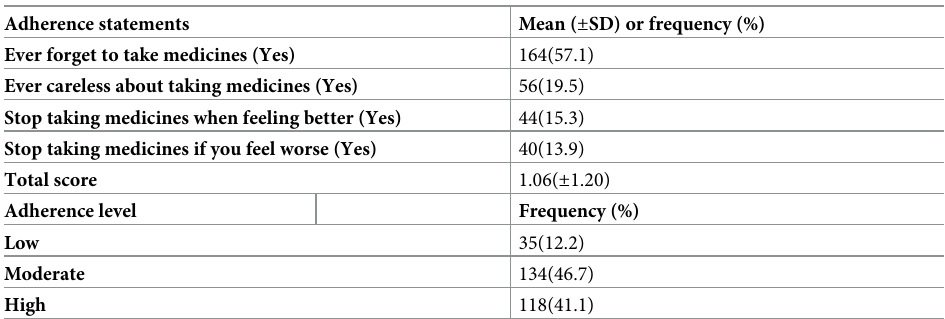
Table 4. The 4-item medication adherence scale.